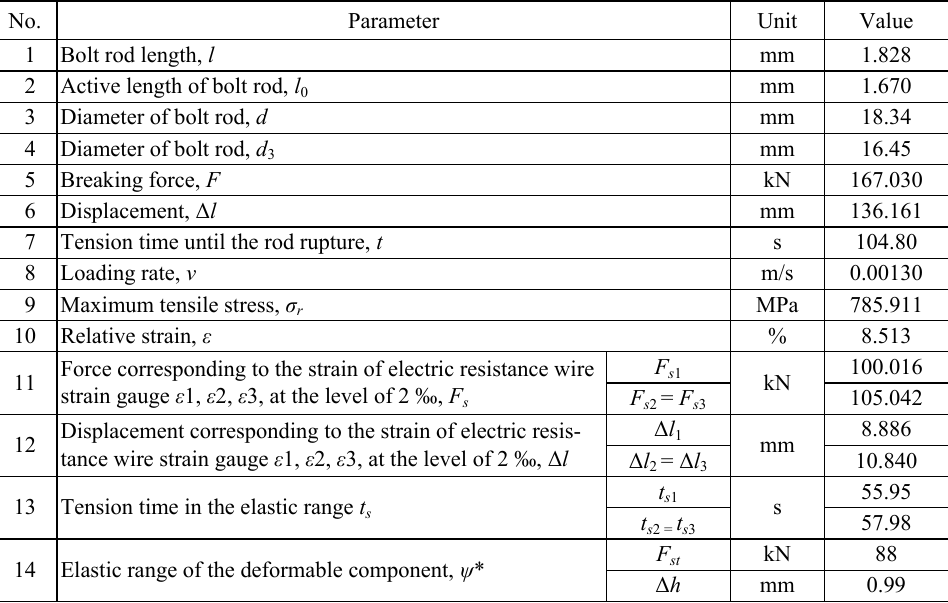
Table 2. Technical specification of the rock bolt support with the deformable component under static tension No.